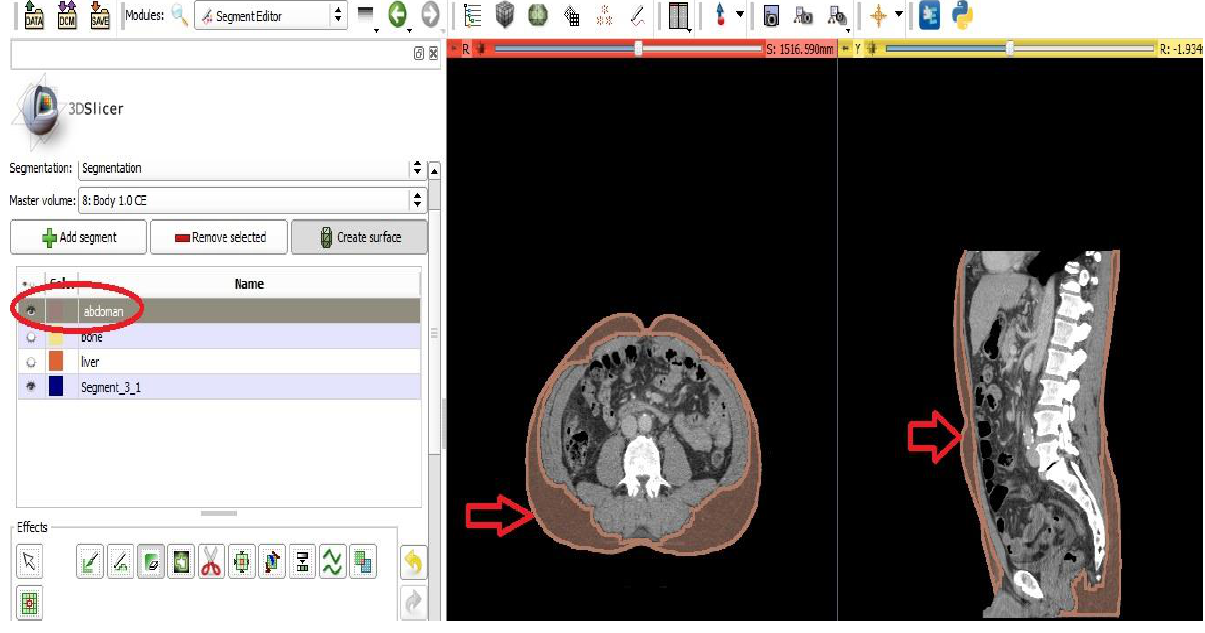
Figure A1: Abdomen segmentation in 3D slicer